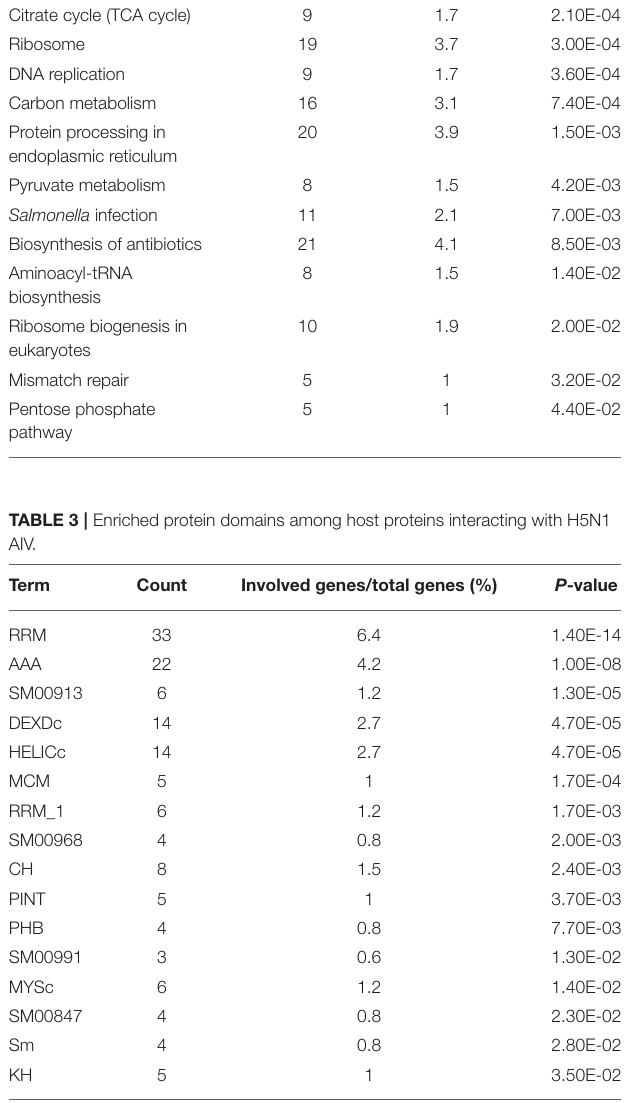
TABLE 2 | Pathway enrichments of host proteins interacting with H5N1 AIV. Term Count Involved P -value genes/ total genes (%)